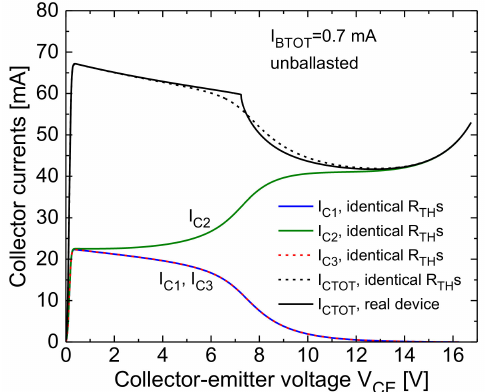
Figure 18. Unballasted 3-cell test device with unit cells sharing ideally identical SH R TH s: simulated collector currents against collector-emitter voltage V CE . Also shown is the I CTOT – V CE characteristic corresponding to the real structure (solid black